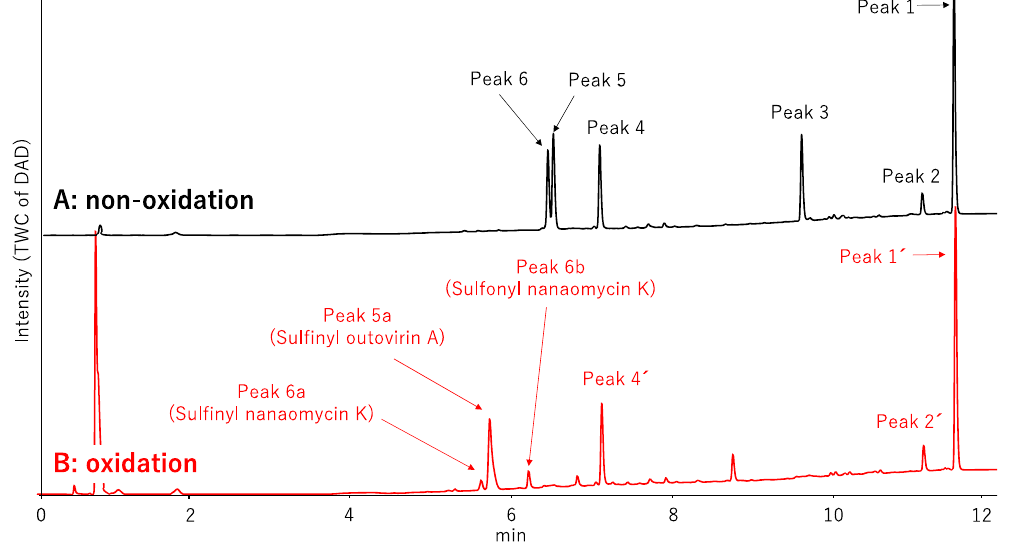
Figure 1. An LC / MS chromatogram of a mixture of compounds with and without sulfur. ( A ) Control (non-oxidized) sample, ( B ) oxidized sample. Intensity refers to the output of a photodiode array detector (DAD) operating in total wavelength chromatography (TWC) mode. Table 1. The structures and LC/MS data of the compounds used in this study. Peak No.